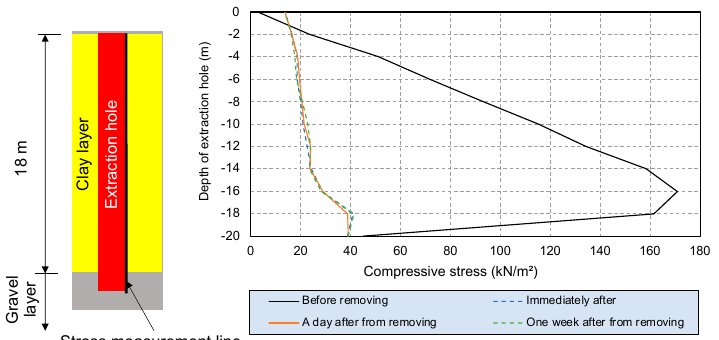
Figure 6. Compressive stress concentrated on one extraction hole of a removed pile.